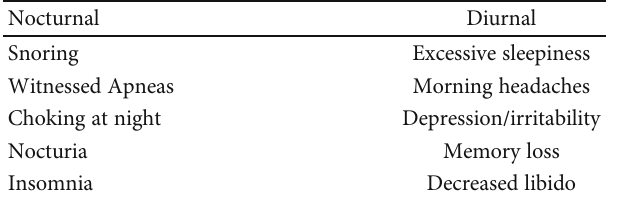
Table 1: Common symptoms associated with